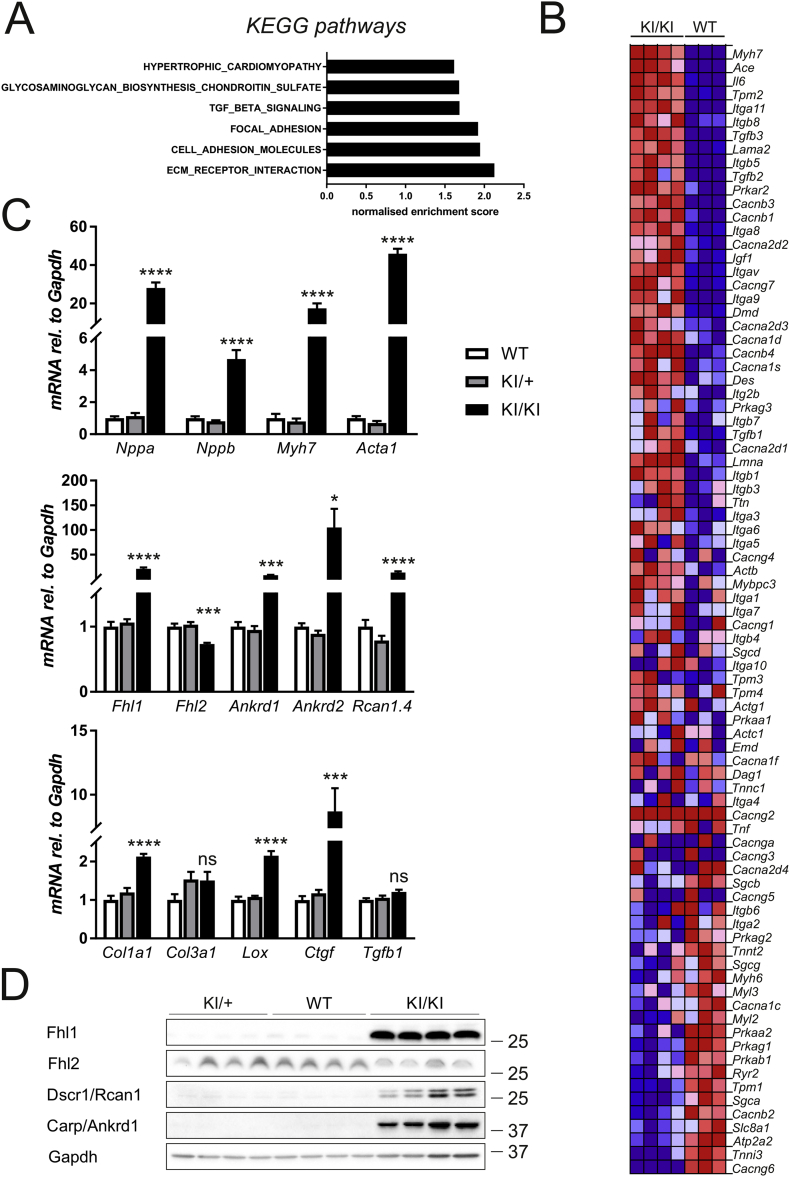
Molecular phenotype of KI/+ and KI/KI hearts. A, B – Transcriptome profiling by RNAseq: A – KEGG Pathway analysis: The top five statistically (p < 0.001) enriched GO terms for KI/KI hearts when compared to WT hearts are shown. B – Heat map shows genes in the KEGG HCM gene set with the strongest up-regulation in the KI/KI hearts at the top and the genes showing the strongest down-regulation at the bottom. Colours range from dark red to dark blue representing respectively the highest and lowest expression of a gene. C – Assessment of transcriptional changes by qPCR for genes related to the fetal gene programme (top), hypertrophic signalling (middle) and fibrosis (bottom). All measurements are normalised to Gapdh; significant changes are observed in the hearts of KI/KI mice; *p < 0.05, ***p < 0.001, ****p < 0.0001 versus WT, n = 6 per group. D – Changes in hypertrophic signalling proteins assessed by Western blotting: Fhl1, Carp (Ankrd1) and Dscr1 (Rcan1) are induced in KI/KI hearts, in line with the activation of hypertrophic signalling pathways. Anti-hypertrophic Fhl2 is down-regulated in these hearts (for quantification see Fig. S5B). Gapdh serves as loading control. The position of marker proteins is indicated (molecular weight in kDa). (For interpretation of the references to colour in this figure legend, the reader is referred to the web version of this article.)